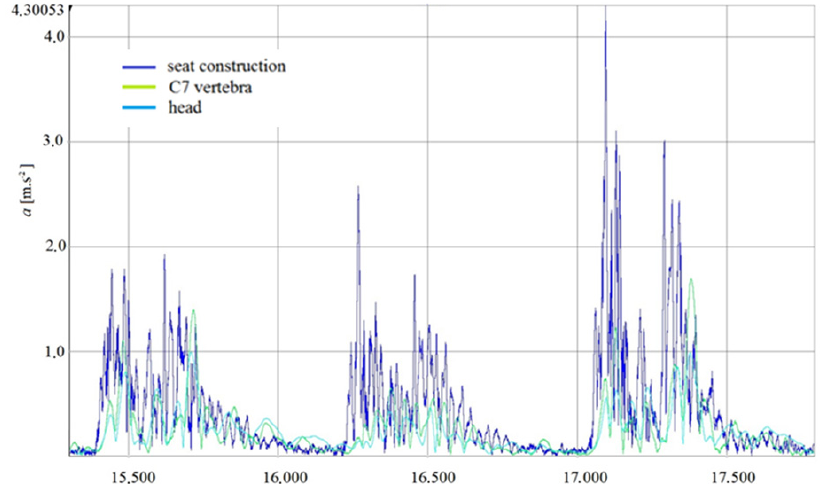
Figure 10. CO-DRIVER (HUMAN)-dependence of acceleration in time of crossing obstacles—V10.